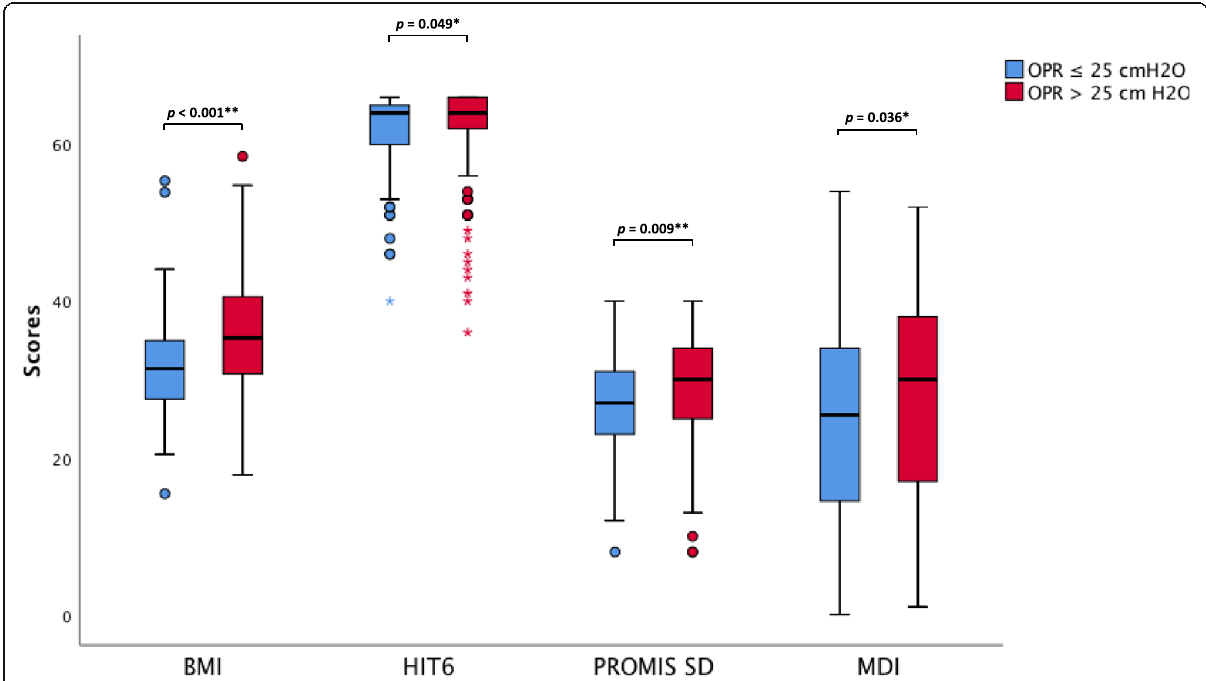
Fig. 2 Comparison of LP OPR ≤ 25 cmH 2 O and LP OPR > 25 cmH 2 O regarding BMI, HIT-6, PROMIS SD and MDI LP OPR. most recently measured lumbar puncture opening pressure, BMI Body Mass Index (kg/m 2 ), HIT-6 Headache Impact Test, PROMIS SD Patient-Reported Outcomes Measurement Information System Sleep Disturbance Short form 8a, MDI Major Depression Inventory, * statistically significant ( p <